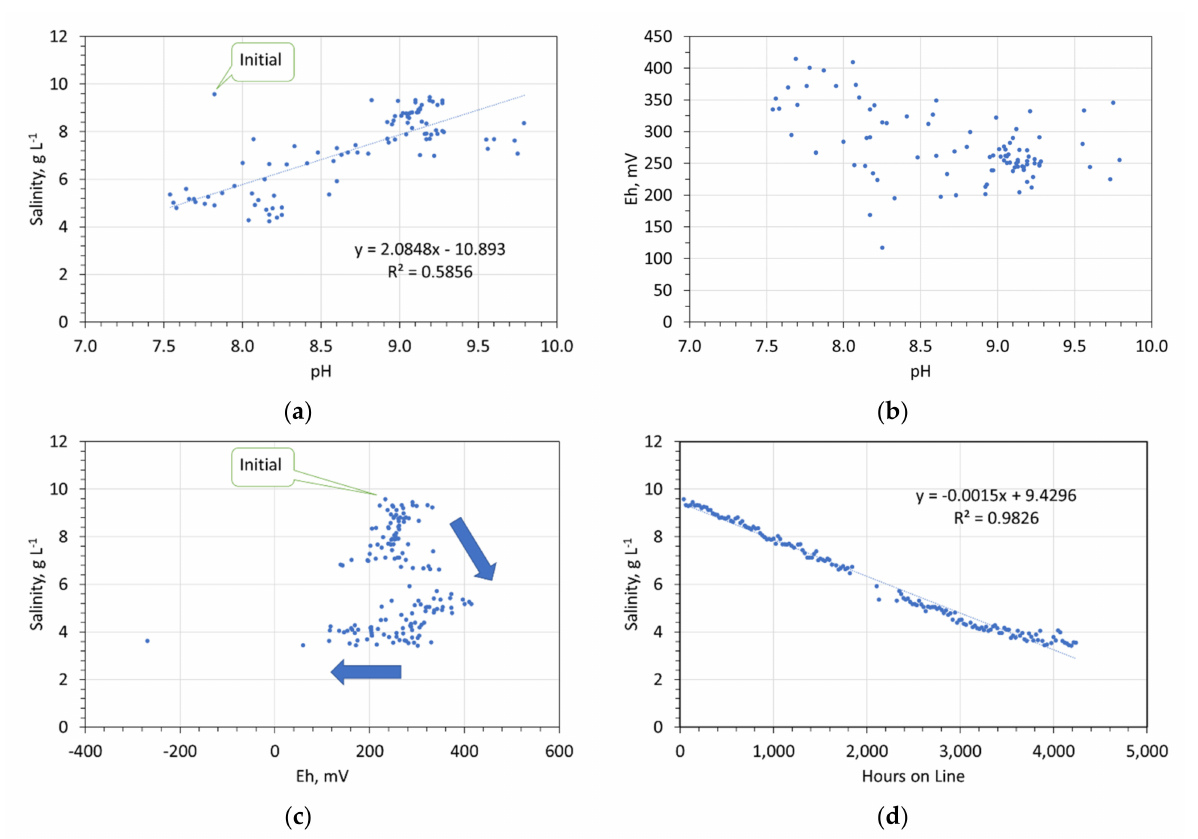
Figure 14. Redox controls on desalination. 47.5 g desalination pellet L − 1 . ( a ) Salinity vs. pH; ( b ) Eh vs. pH; ( c ) Salinity vs. Eh; ( d ) salinity vs. hours on